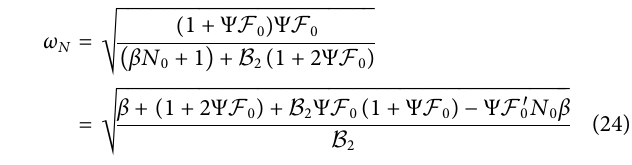
Frontiers in Physics |